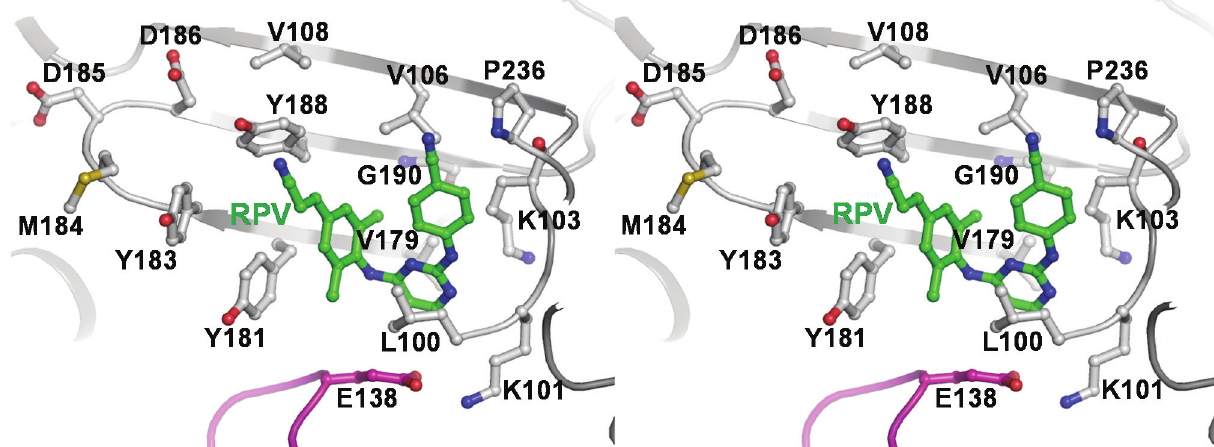
Figure 5. Amino acids involved in HIV-1B NNRTI resistance: Stereoview of HIV-1B RT with RPV bound at the NNIBP and NNRTI-resistance residues and RPV shown in ball-and-stick representation. The RT backbone (PDB file 2ZD1) [30] is shown in ribbon representation (p66 in light gray and p51 in magenta). Amino acid side chains are colored with carbon in white, oxygen in red, nitrogen in blue, and sulfur in yellow. RPV carbons are shown in green and nitrogens in blue. RPV resistance residue E138 [103,104,119–121] is shown in magenta. Residues 227, 229, and 234 are omitted for